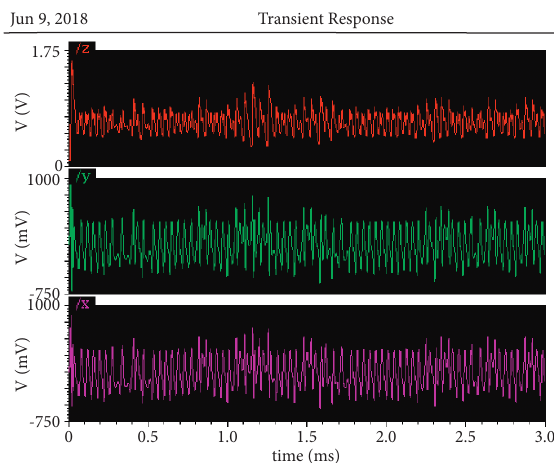
Figure 8: Transient response of the Chen chaotic circuit.